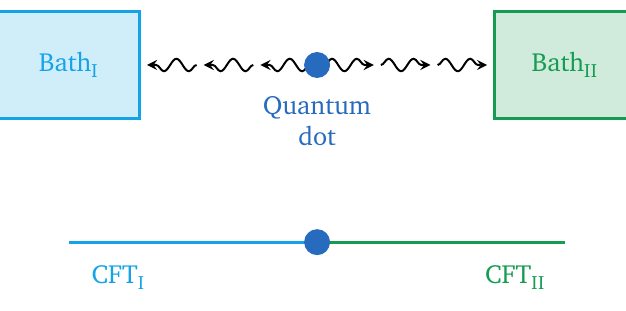
Figure 2: A possible physical interpretation of the system: a quantum dot coupled to two baths. The quantum dot has finite entropy, the boundary entropy of the defect, and if we put the system in the thermofield double state the dot can be seen as an eternal black hole coupled to two